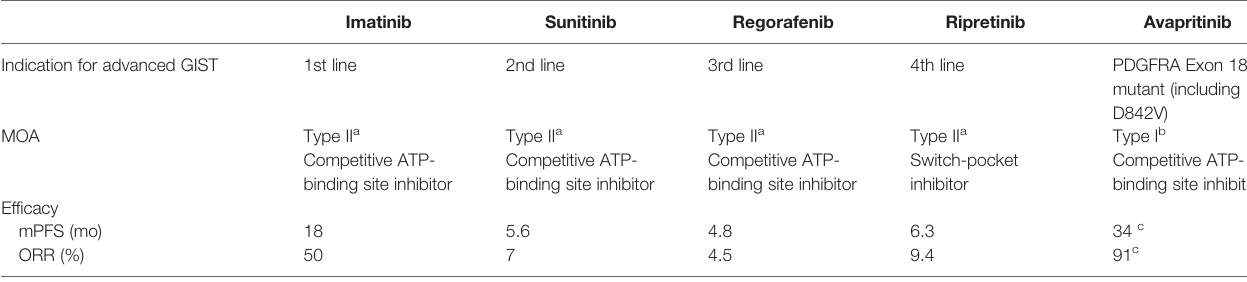
a Binds the inactive con fi rmation. b Binds the active con fi rmation. c D842V patients only. GIST, gastrointestinal stromal tumor; mo, months; MOA, mechanism of action; mPFS, median progression-free survival; ORR, overall response rate; PDGFRA, platelet-derived growth factor receptor